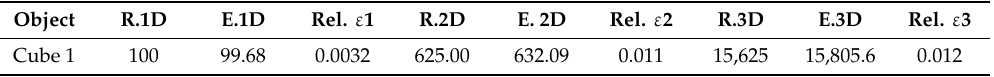
Table 5. Cube real measurements (R.1D, R.2D, R.3D), their estimates in cm (E.1D, E.2D, E.3D), and their relative errors.